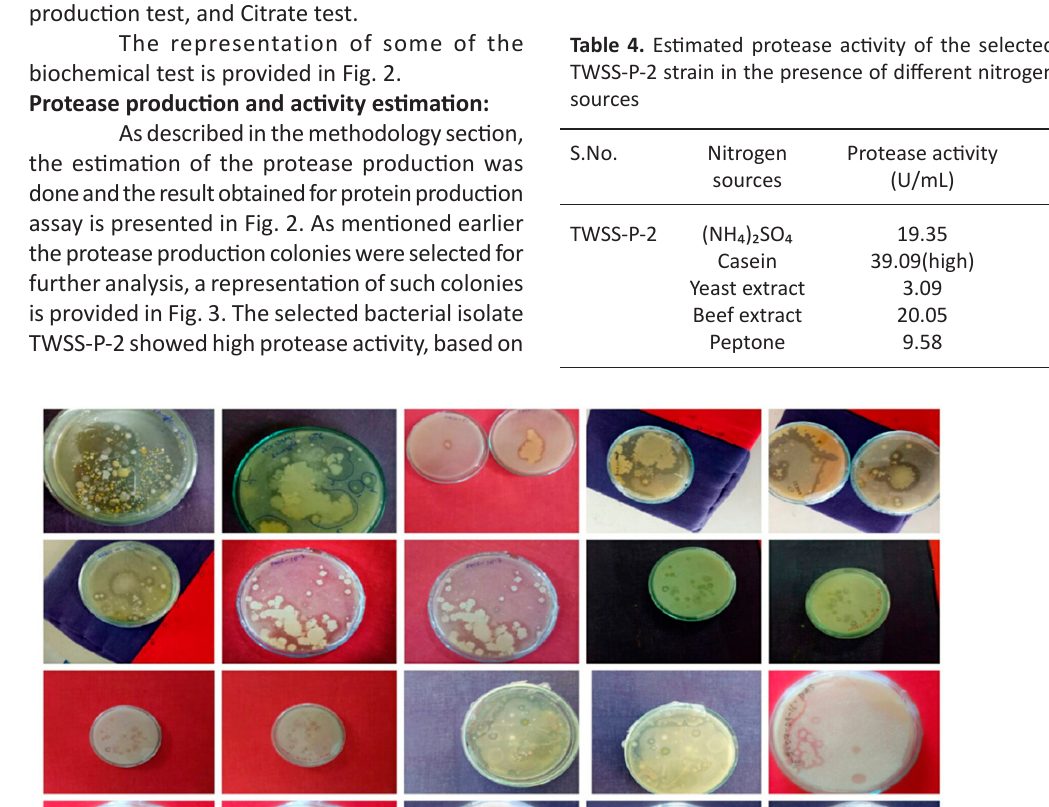
Table 4. Estimated protease activity of the selected